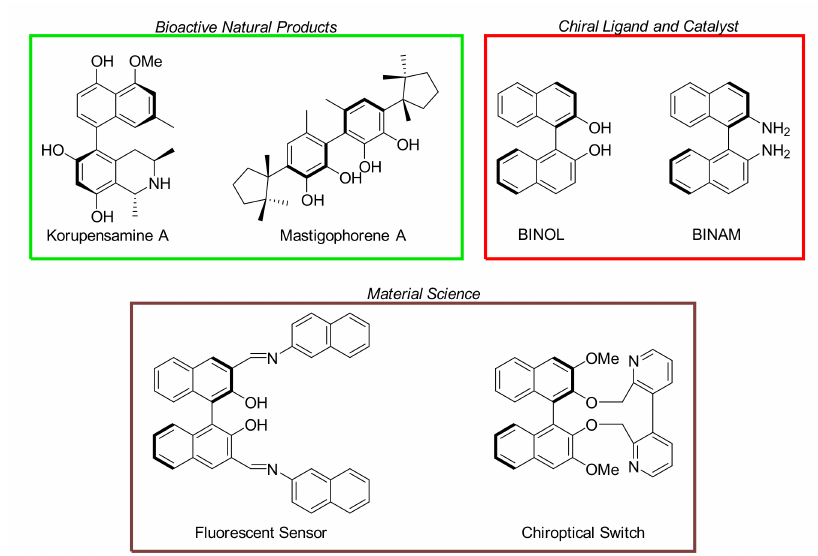
Figure 1. Example of biaryl scaffolds and their